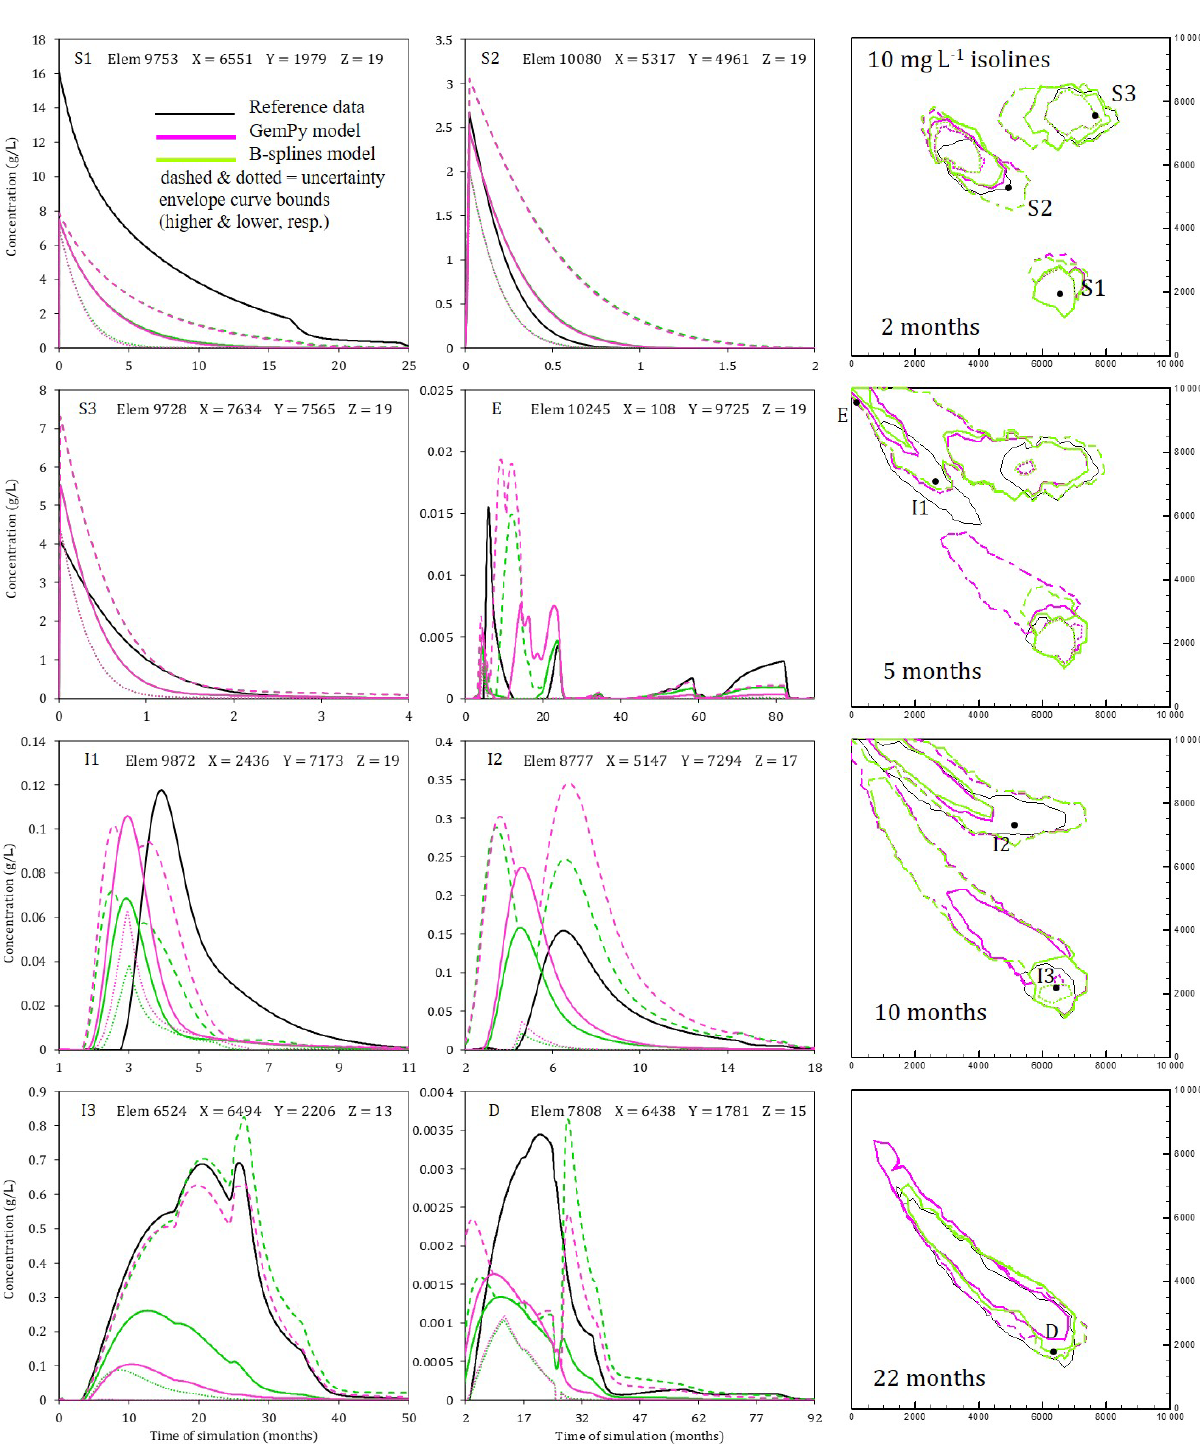
Figure 9. Contamination breakthrough curves. GemPy (green) and B-spline (yellow) parametrized models (dashed for sparse data) are compared to the initial synthetic dataset (black). The two columns on the left show depletion or breakthrough curves, and the last column on the right depicts contamination plumes at four different